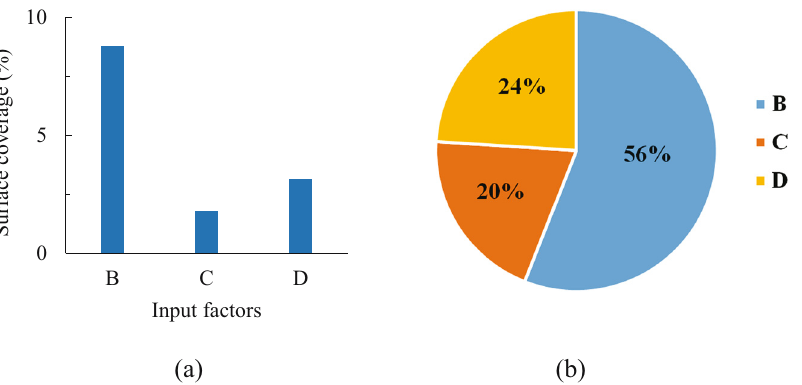
Figure 2: Diagram of the range value on surface coverage ( a ) and normalized ( b ) at the initial state to various input